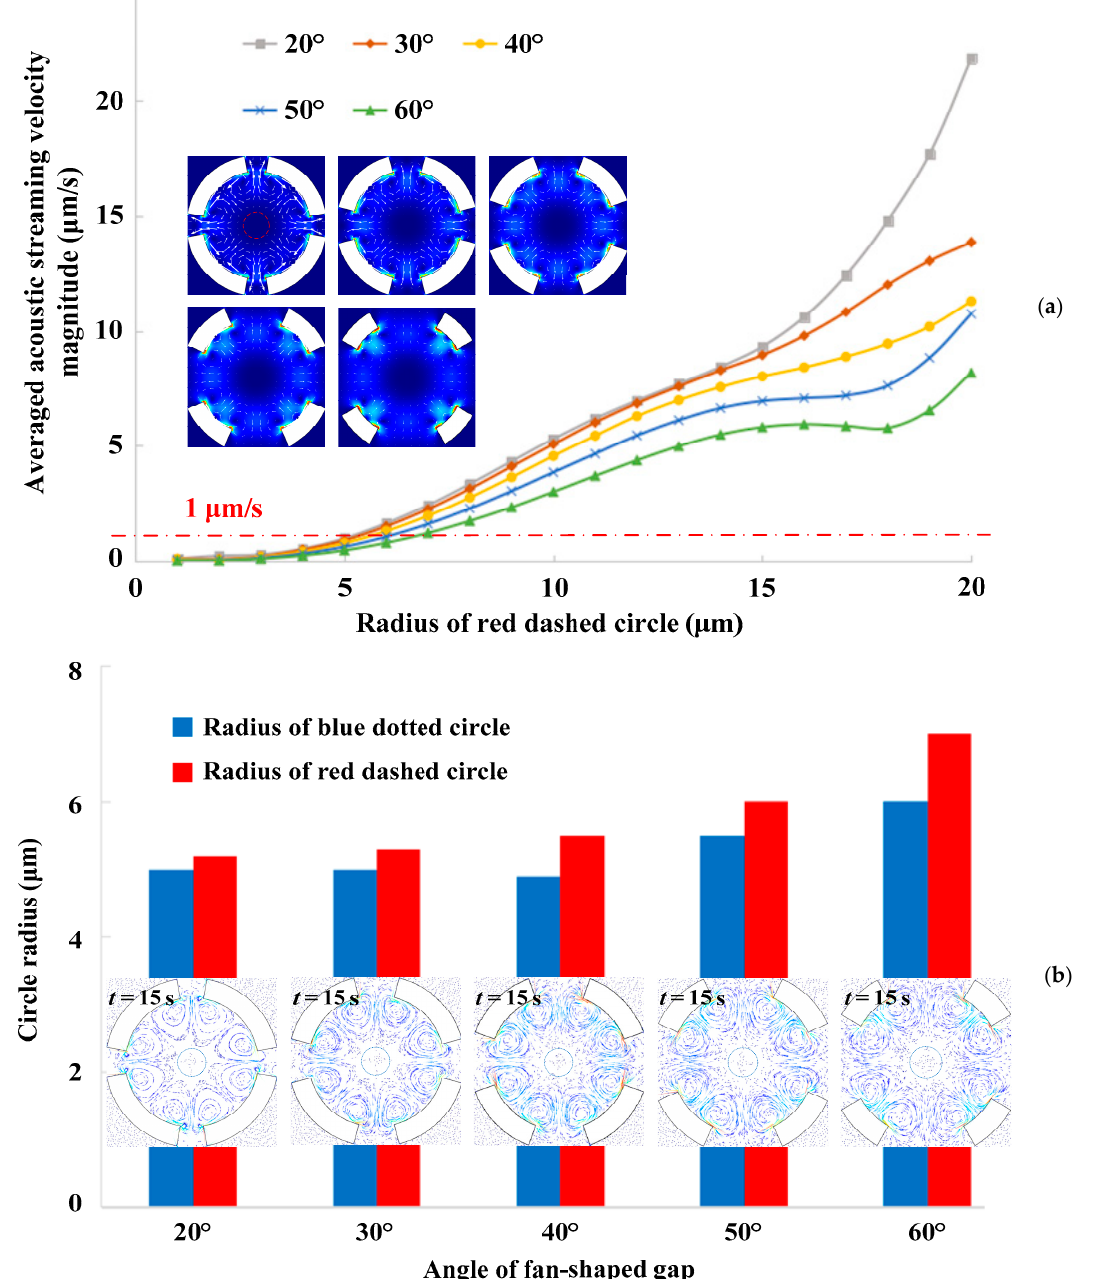
Figure 3. (Color online). Acoustic streaming field and particle trajectory excited by four vibration sources with the same initial phase and different fan-shaped gap angles. ( a ) Averaged acoustic streaming velocity magnitude vs. radius of red dashed circle. ( b ) Different circle radii vs. angle of fan-shaped gap.